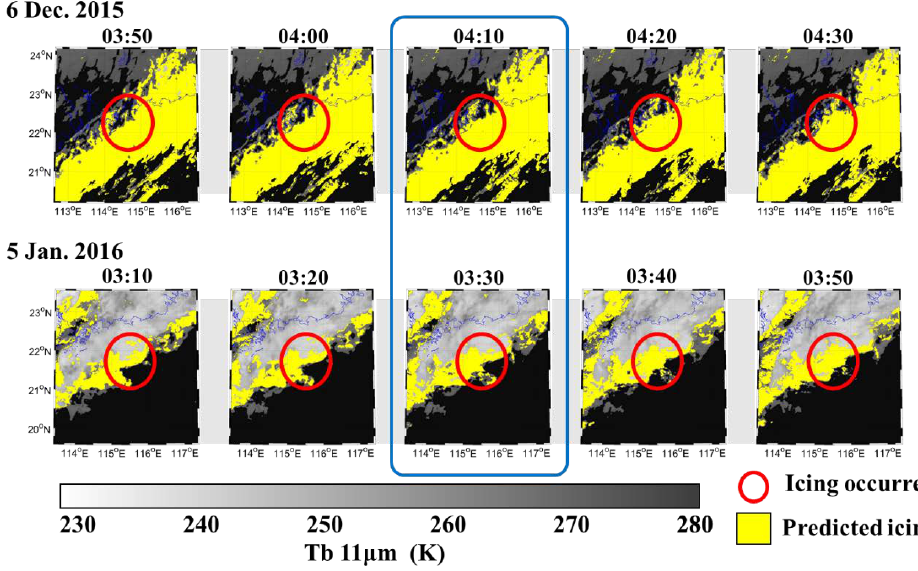
Figure 8. Time-series of potential icing areas when the Himawari-8 RF model was applied for two icing cases (i.e., the upper images on 6 December 2015 04:15 UTC at E22.19 ◦ and N114.60 ◦ and the bottom images on 5 January 2016 03:30 UTC at E21.58 ◦ and N115.41 ◦ ). The corresponding 11 µ m channel images were used as the